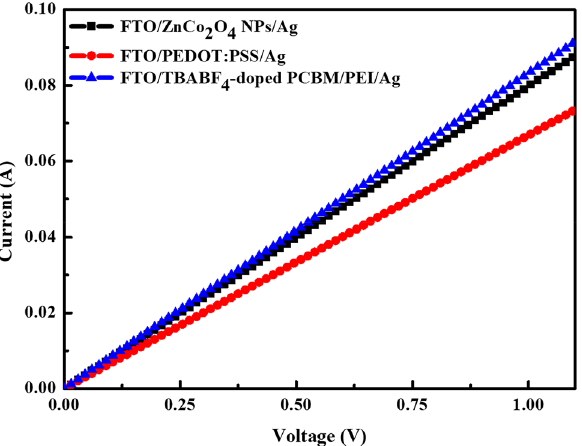
Figure 6. Current–voltage characteristics of hole-only devices FTO/ZnCo 2 O 4 NPs or PEDOT:PSS/Ag and electron-only device FTO/TBABF 4 -doped PC 61